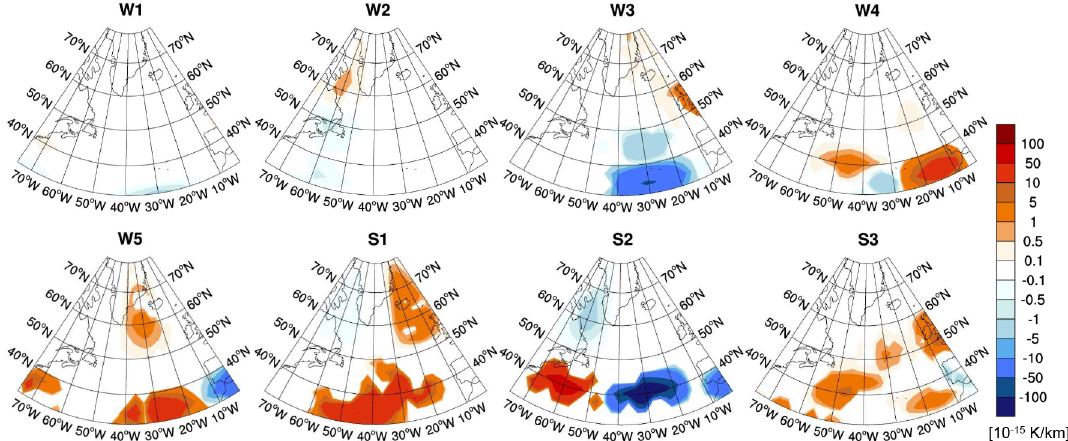
Figure 7. Climate change functions of contrail cirrus at 250hPa in 10 − 15 K per kilometre flown for eight representative weather situations and an emission at 12:00UTC. CCFs for other pressure levels and times investigated in this study are presented in the Supplement.